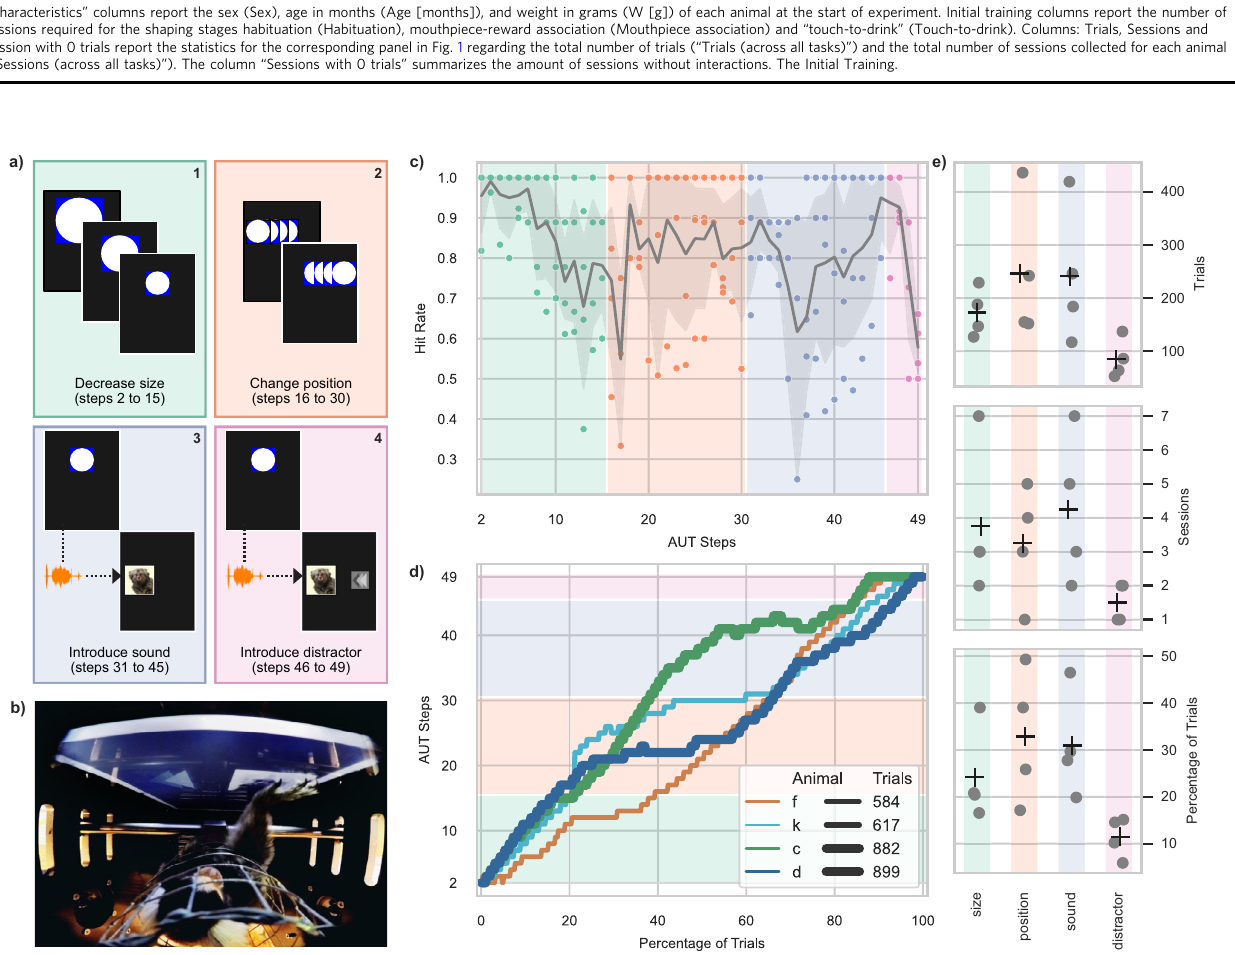
Fig. 2 Automated unsupervised training (AUT) performance across four representative animals. a Schematics of the four main milestones of the fi nal AUT protocol. b Picture taken with an external high-resolution wide-angle camera, where an animal can be seen completing a trial. c Average hit rate as a function of steps (gray area represents the 95% con fi dence interval of the mean across animals) across the four animals considered in this analysis. d Percentage of trials spent on each AUT step and milestones (shaded background) with line thickness indicating the total amount of trials performed by the corresponding animal. e Distributions of number of trials, number of sessions, and percentage of total trials for each milestone across the four naïve animals (crosses represent average